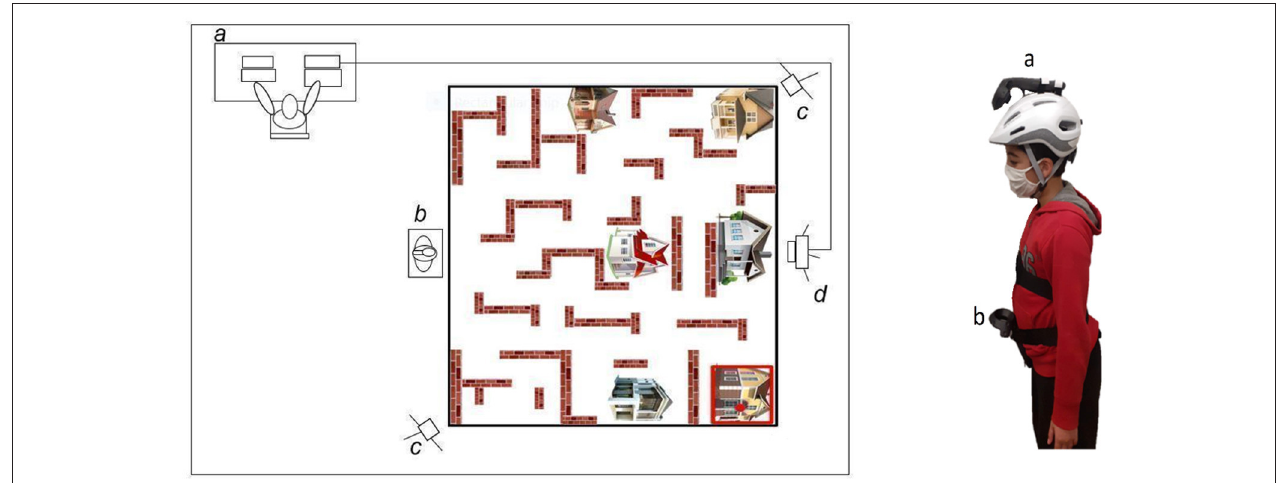
FIGURE 1 | (A) The representation of the experimental setup: (a) control desk location where the experimenter runs the experiment, (b) departure point, (c) two HTC Vive cameras, (d) the video projector. (B) 3D motion sensors motion-tracker. (a) one handheld 3D motion sensor is adapted to a bike helmet and is worn on the participant’s head and (b) the second handheld 3D motion sensor is attached to the belt which worn on the participant’s waist.